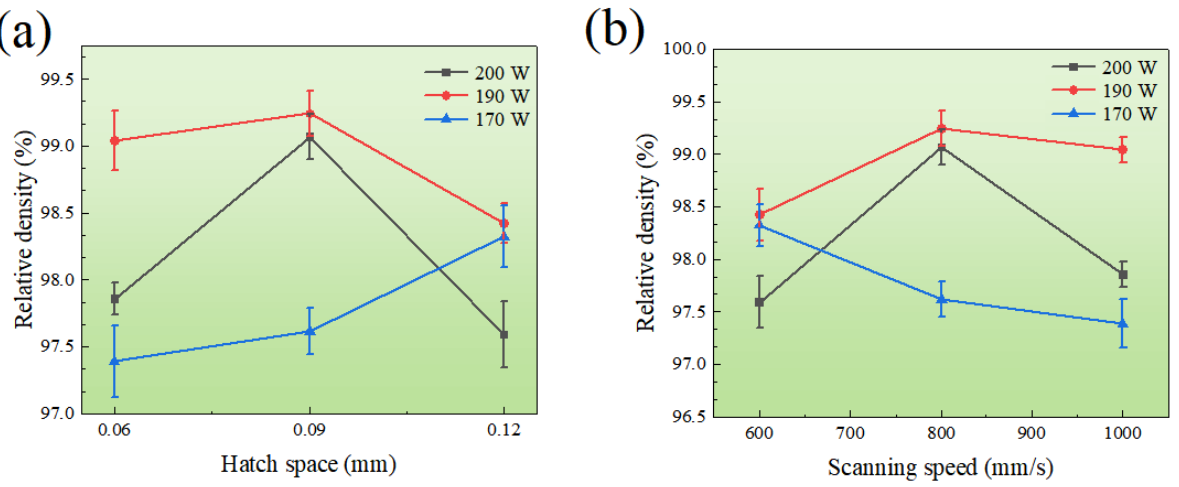
Figure 3. The RD depended on hatch space ( a ) and scanning speed ( b ) under different heating power levels of 170, 190 and 200 W.